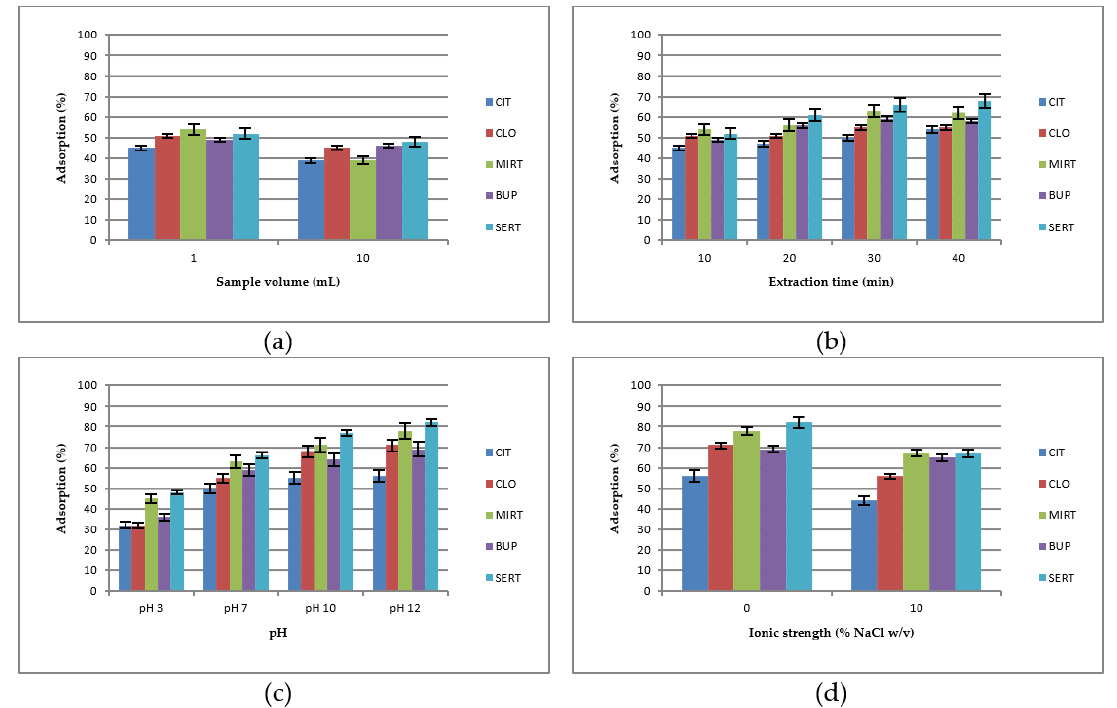
Figure 1. Efficiencies of the five antidepressants (ADs) during the adsorption step depending on ( a ) the volume of the sample, ( b ) extraction time for 10, 20 30 and 40 min under stirring, ( c ) different pH values, and ( d ) ionic strength; citalopram (CIT), clozapine (CLO), mirtazapine (MIRT), bupropion (BUP), sertraline (SERT).